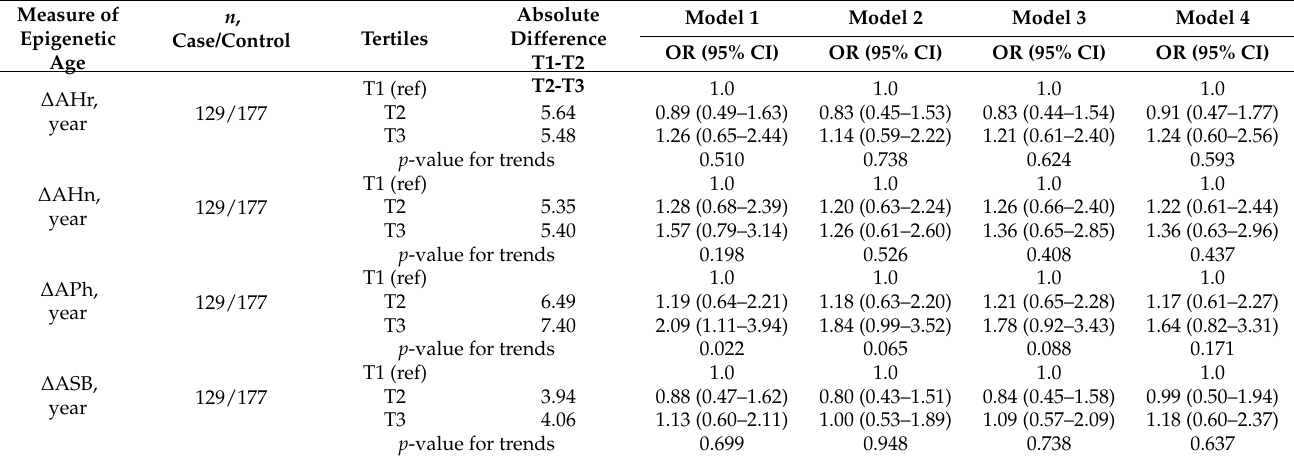
Table 3. Relationship between MI/ACS and epigenetic age acceleration by tertiles of the difference between baseline EA and CA (cases, n = 129 and controls, n =